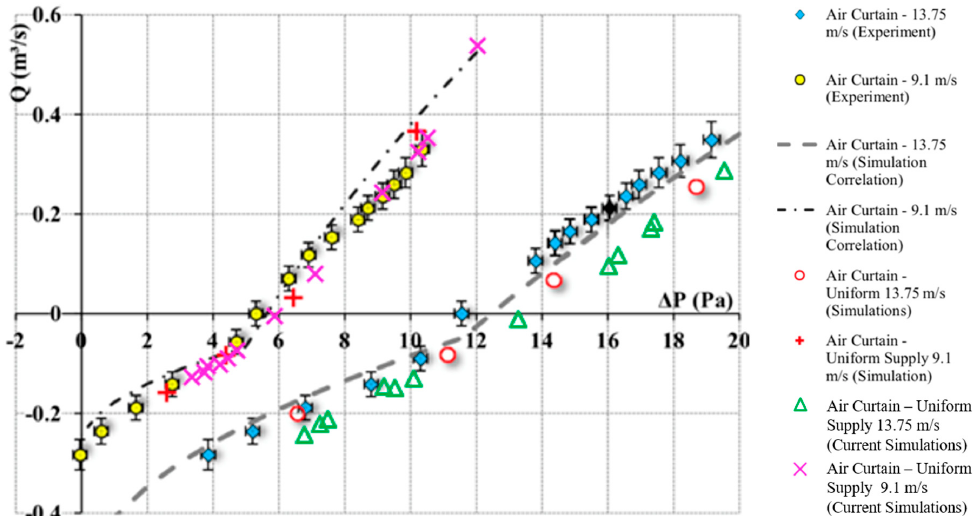
Figure 8. Comparisons among the current CFD results Q - ∆ P for the air curtain with uniform supply and the previous experimental and numerical results [28].